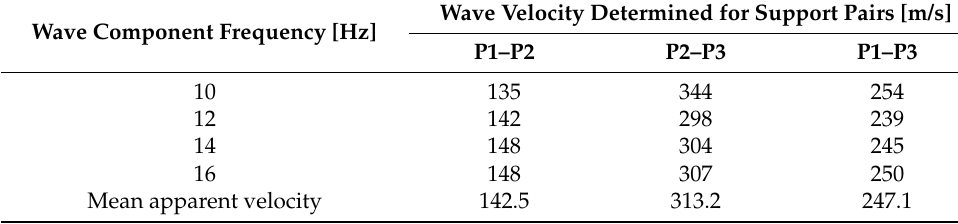
Table 4. The wave velocities between piers determined from the cross-correlation functions. Wave Component Frequency [Hz]